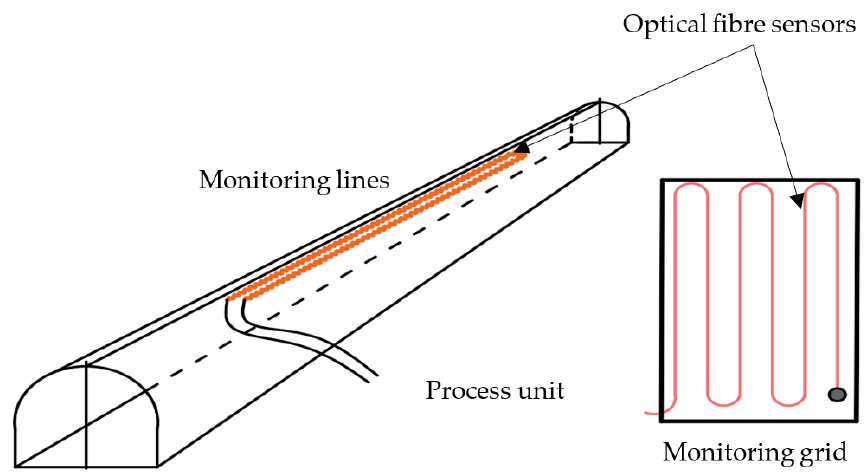
Figure 8. Scheme of different types of monitoring systems using optical fiber sensors.